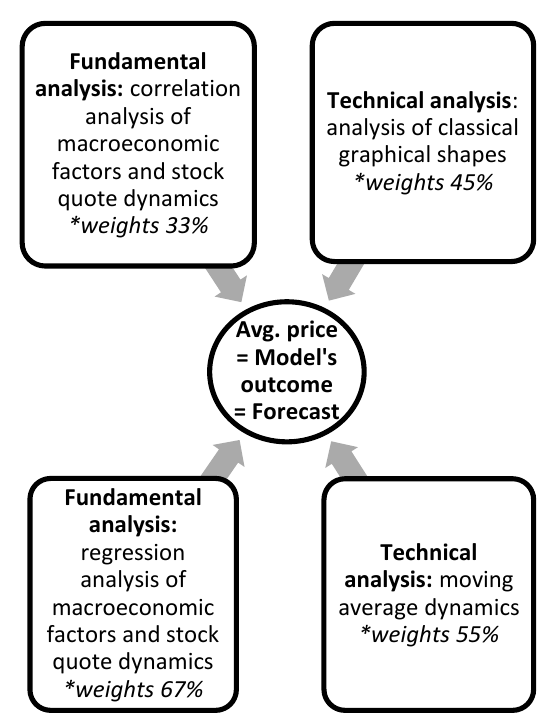
Fig. 2. Final variant of graphical interpretation of complex-weighted forecasting model (Source: compiled by